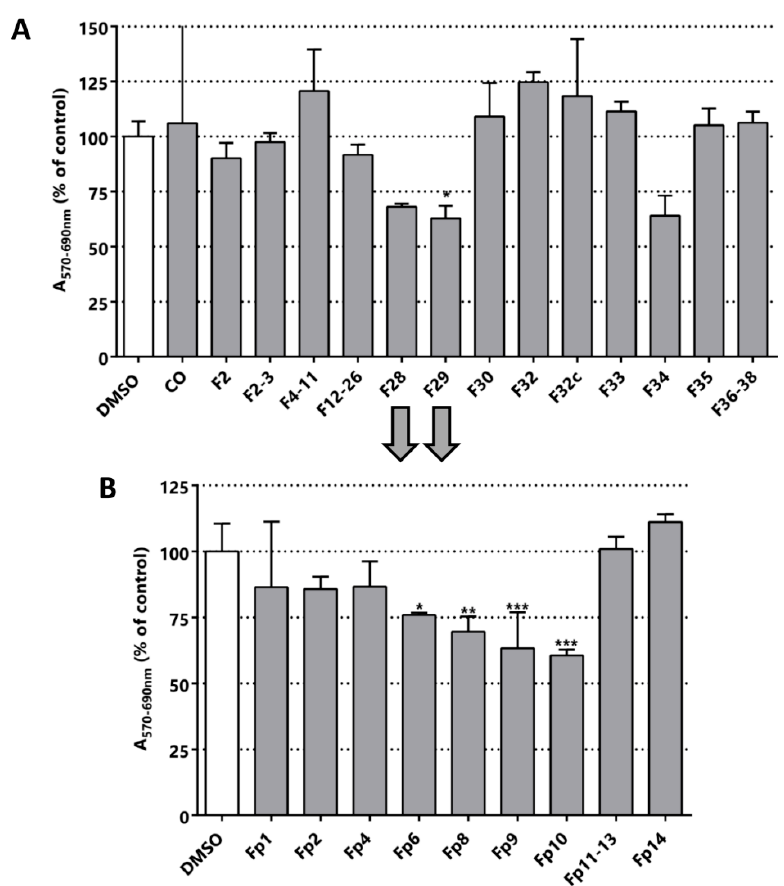
Figure 3. Bioguided fractionation. Cytotoxic/anti-proliferative activity of the L. leucocephala extracts (25 μ g/mL) in LNCaP cells. ( A ) Evaluation of the fractions obtained from the silica chromatography of the methanolic extract of L. leucocephala . CO is the organic phase after the extraction with ethyl acetate/water. ( B ) Evaluation of the fractions obtained by preparative chromatography, particularly fractions F28 and F29. The nomenclature of the fractions corresponds to the chromatographic elution time. Statistical significance is * p < 0.05; ** p < 0.01; *** p < 0.001.